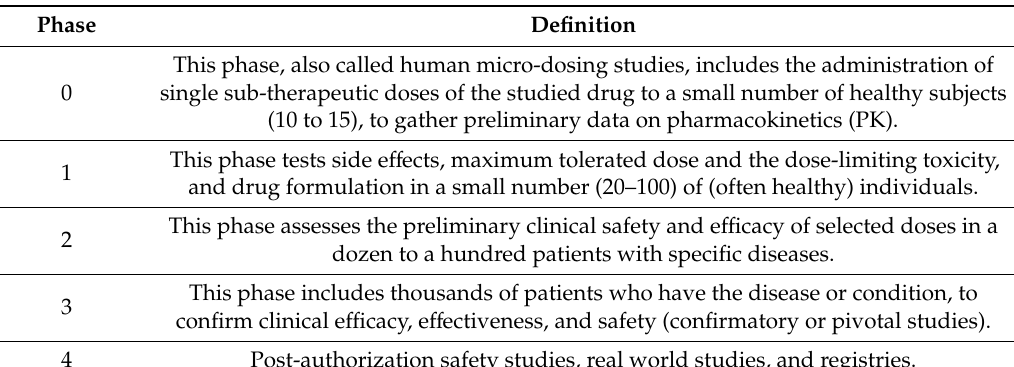
Table 1. Definition of clinical